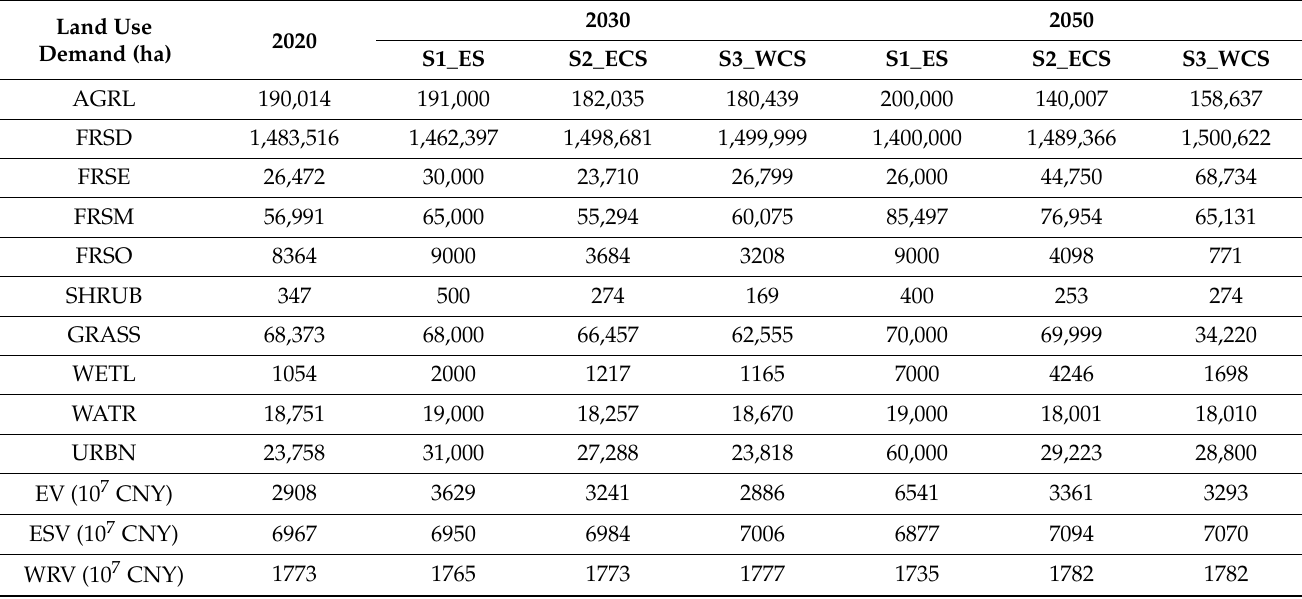
Table 7. Land use demand forecast for 2030 and 2050. Land use code is the same as in Table 1. Land